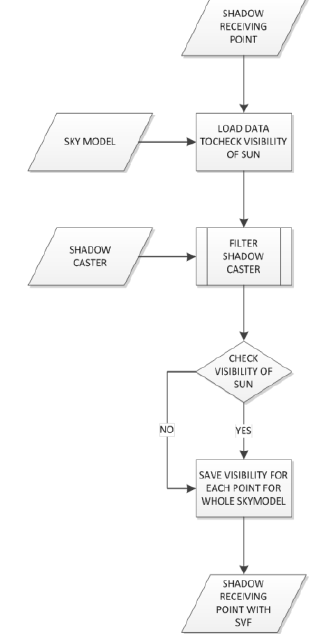
Figure 4: Workflow for SVF calculation for each shadow receiving